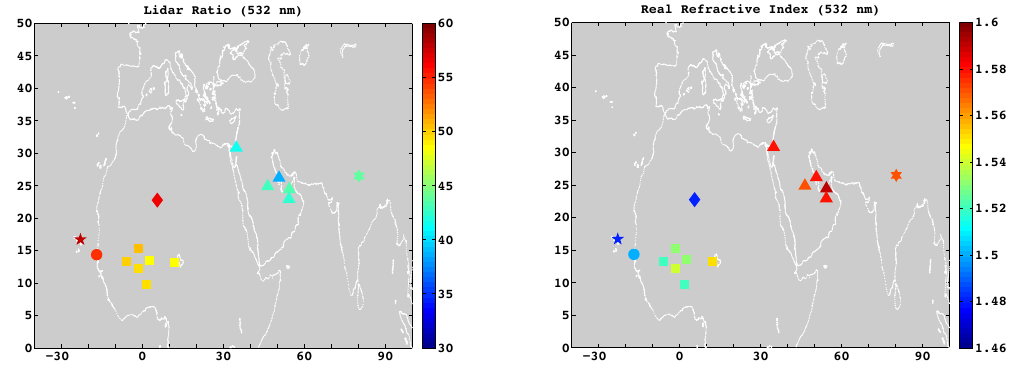
Fig. 8. Left panel: Median lidar ratios computed for Level 2.0 AERONET retrievals approximating “pure” dust (i.e., depolarizations greater than 0.2 and fine volume fractions less than 0.05). Right panel: same retrievals as left panel, except the median real refractive index at 0.532 µ m is shown. Both lidar ratio and refractive index indicate regional consistency and large scale variability (i.e, non-Sahel Africa is different than the African Sahel and the Middle East).